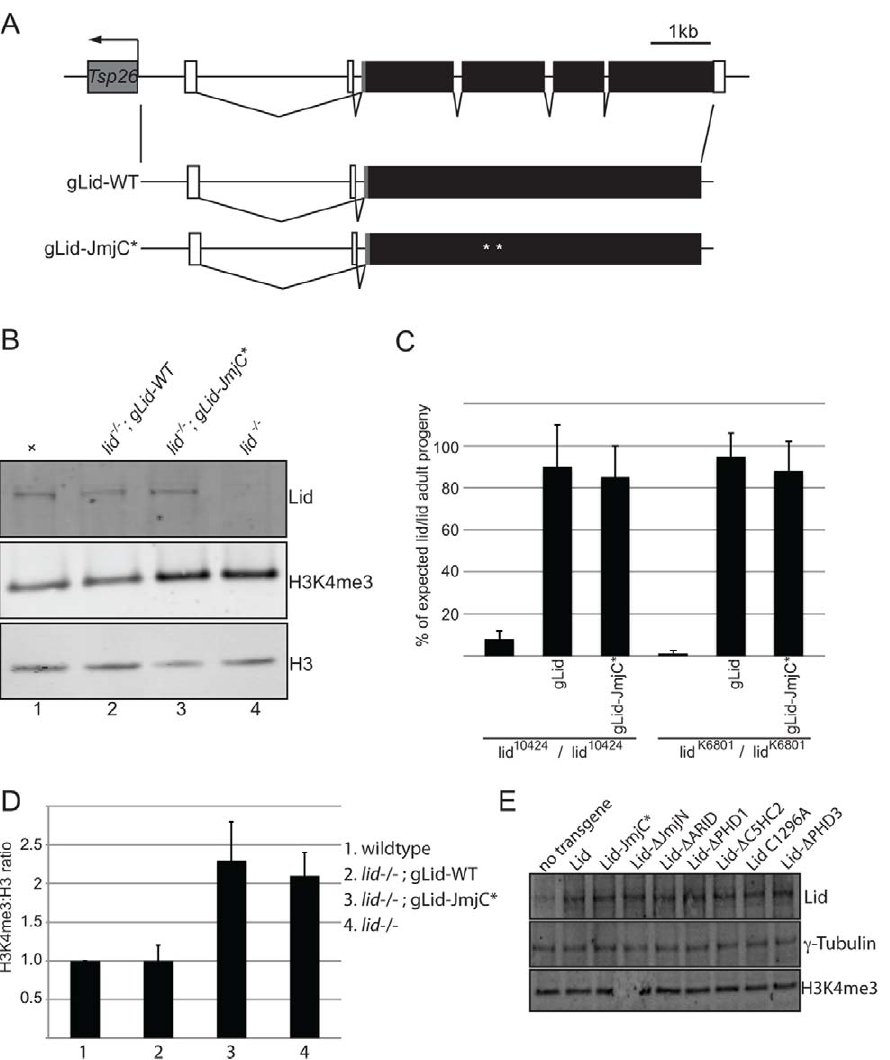
Figure 2. Wildtype and demethylase inactive genomic rescue transgenes can rescue lid mutant animals. (A) Schematic representation of wildtype and mutant rescue transgenes in which 4.6 kb of upstream regulatory region fused to a Lid cDNA. (B) Western blot analysis of wing discs using anti-Lid, anti-H3K4me3 and anti-histone H3 in wildtype (lane 1), lid/lid ; gLid-WT, (lane2), lid/lid ; gLid-JmjC* (lane 3) and lid 10424 homozygous ( lid/ lid , lane 4). (C) Quantitation of rescue based on the % of each genotype expected based on Mendelian genetics from the cross of lid 10424 /CyO (or lid K6801 /CyO) females to lid 10424 /CyO; gLid-WT or gLid-JmjC* males in uncrowded (10 females per cross) conditions. (D) Quantitation of H3K4me3:H3 ratios from three independent experiments described in (B). (E) Western analysis of wing discs from Actin-Gal4 based rescue crosses. 12 wing discs were used per lane and the Western probed with anti-Lid, anti-H3K4me3 and the loading control c -tubulin.